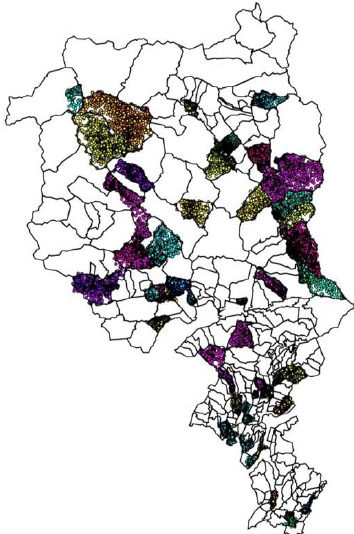
Figure 2. Present state of progress in reviewing and publishing the toponymic heritage of Canton Ticino. In 50 municipalities, covering around 800 km 2 , 30.000 place names have been georeferenced and